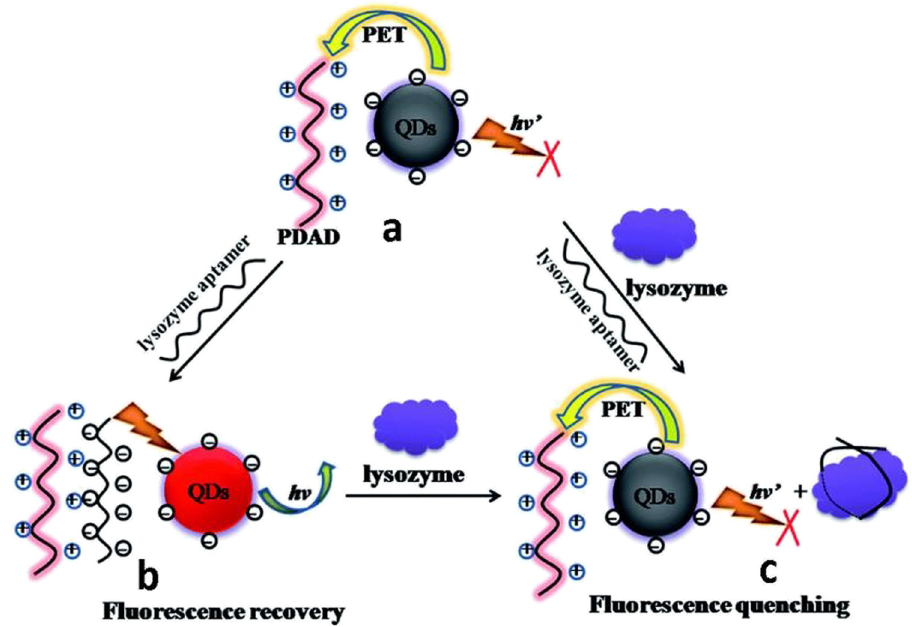
Figure 4: Strategy for lysozyme sensing. ( a ) Coexistence of the MPA - capped CuInS 2 QDs and cationic polyelectrolyte PDAD. ( b ) Electrostatic bonding of the lysozyme aptamer and PDAD. ( c ) Bonding of the lysozyme aptamer and lysozyme; with permission from ref. [ 86 ] ; Royal Society of